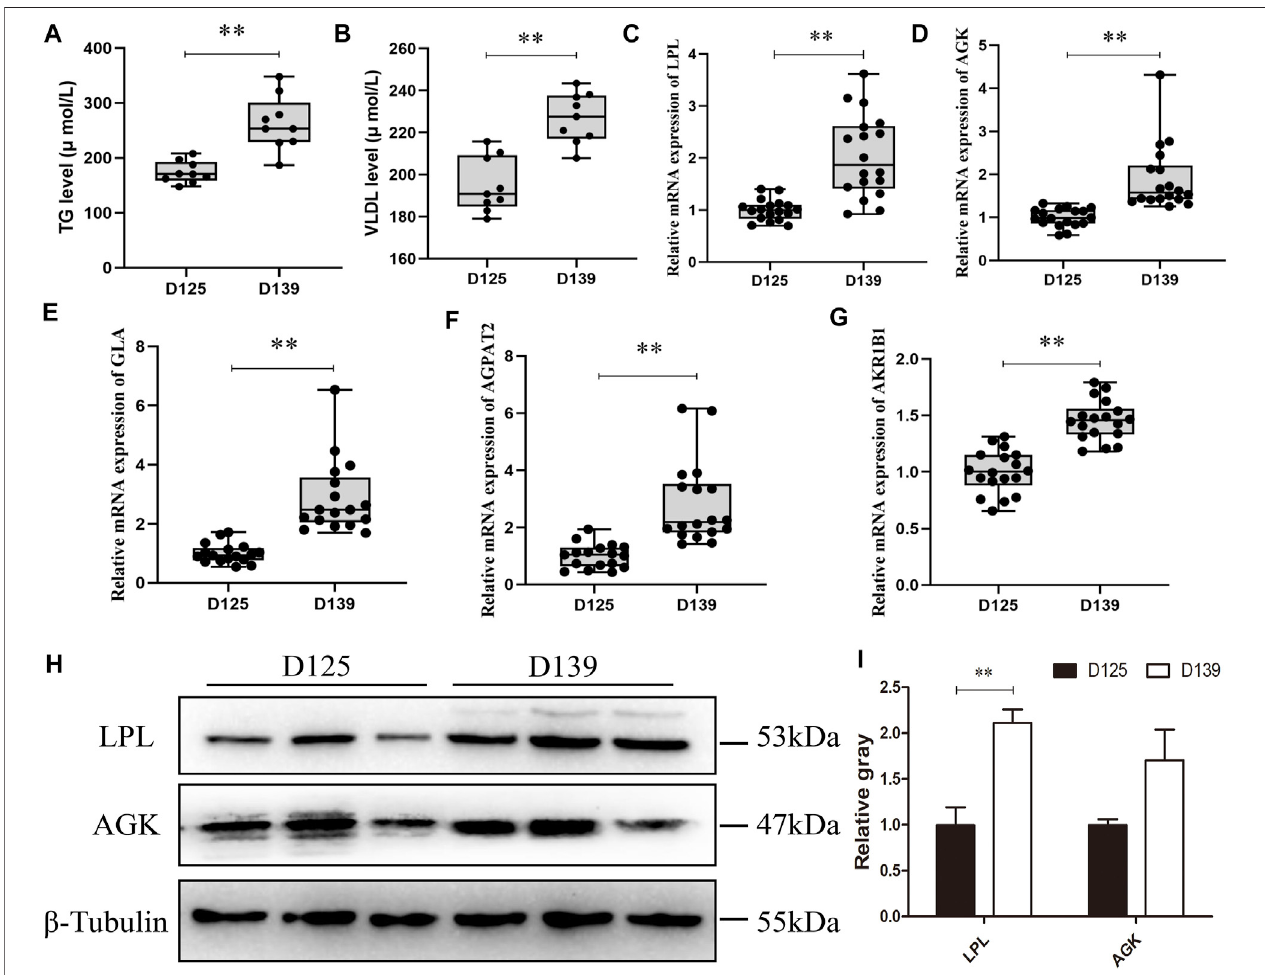
FIGURE 7 | The validation results of the DEPs enriched in the glycerolipid metabolism pathway. (A,B) The concentration of TG and VLDL in chicken serum was detected in D125 and D139. (C – G) qRT-PCR and (H,I) western blot were performed to validate the DEPs enriched in glycerolipid metabolism pathway. Data are presented as mean ± standard error (SE); * p < 0.05 and ** p <